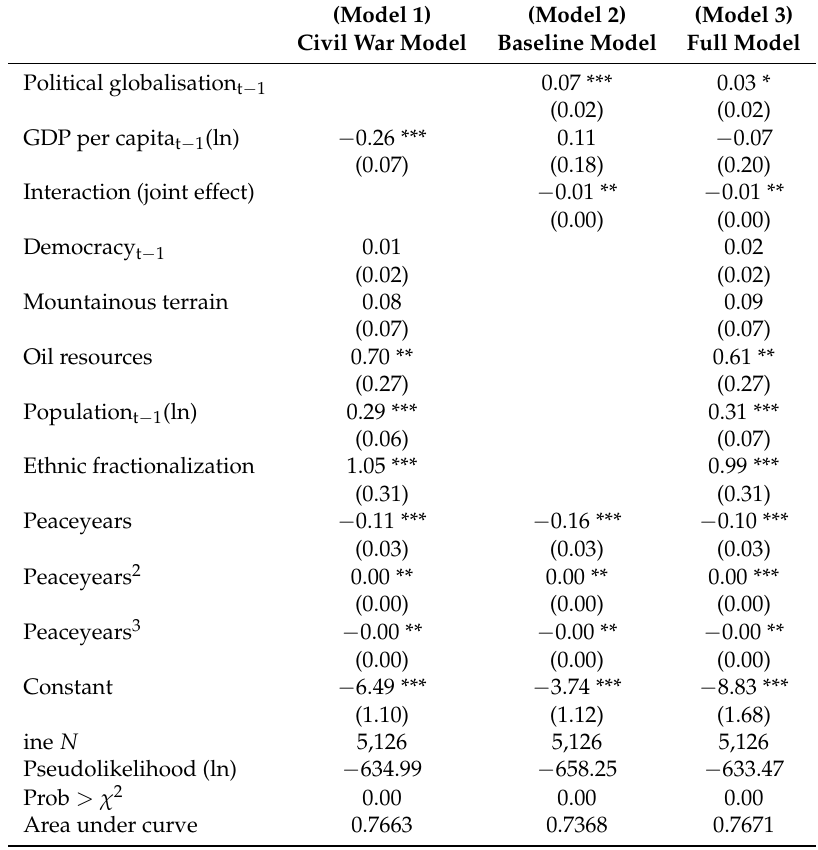
Table 2. Civil war onset and state